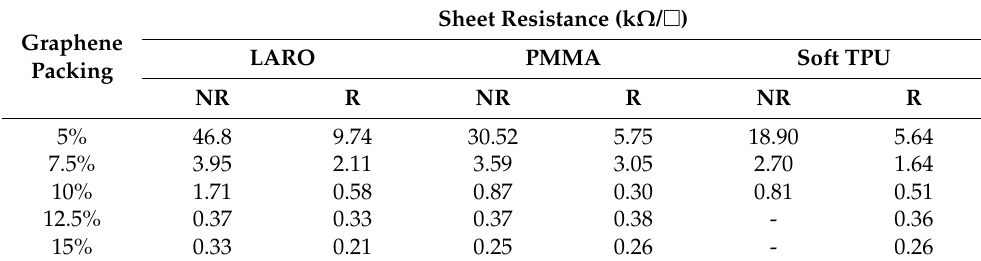
Sheet Resistance (k Ω / (cid:3) )